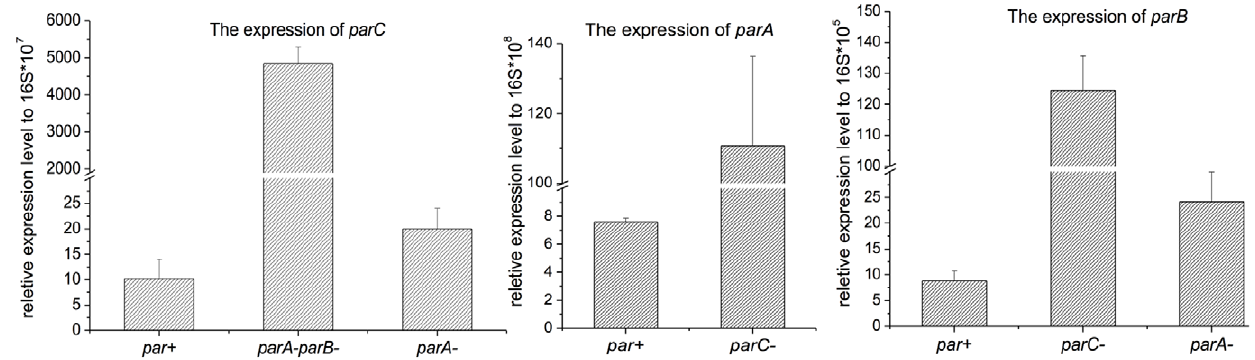
Figure 7. Quantitative PCR analysis. The gene expression of parC , parA and parB of the deletion mutants of pXS13 ( parC 2 ), pXS14 ( parA 2 ) and pXS16 ( parA 2 parB 2 ) relative to that of the 16S gene and compared to that of the transformant of pXS11 ( par + ).